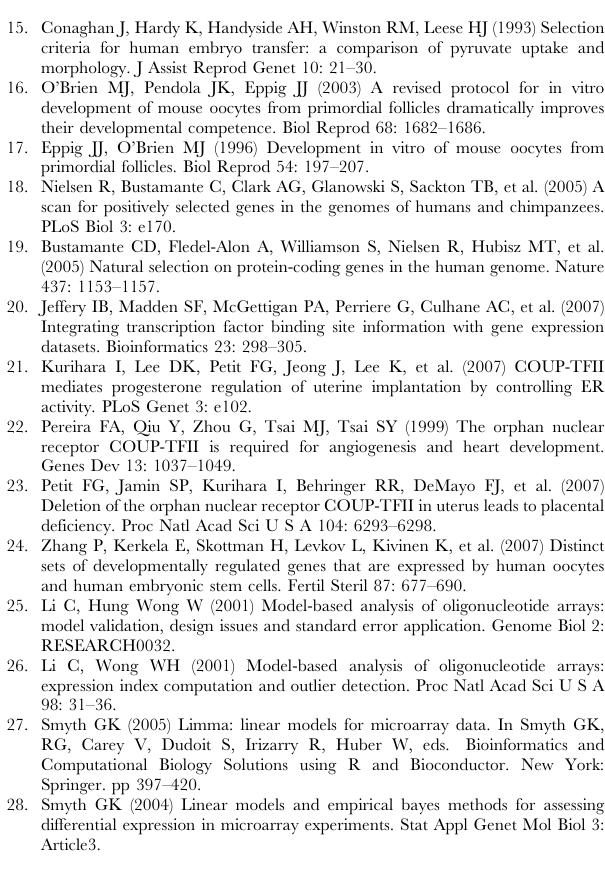
Figure S3 Correlation between chips (right) and hierarchical clustering of the arrays (left) based on the Pearson correlation coefficient Found at: doi:10.1371/journal.pone.0007844.s022 (8.87 MB TIF) Figure S4 Correlation between replicates. The expression values of the repilcates (in log2 scale) are plotted against each other Found at: doi:10.1371/journal.pone.0007844.s023 (1.40 MB TIF) Figure S5 High and low expressed probe sets for p-value = 0.05 (left), p-value =0.005 (center) and p-value =0.0005 (right). Yellow bars represent the number of probe sets with lower expression, the orange those with higher expression and the red ones the sum of the two Found at: doi:10.1371/journal.pone.0007844.s024 (9.93 MB TIF) Figure S6 High and low expressed probe sets for p-value = 0.05 (left), p-value =0.005 (center) and p-value =0.0005 (right). Yellow